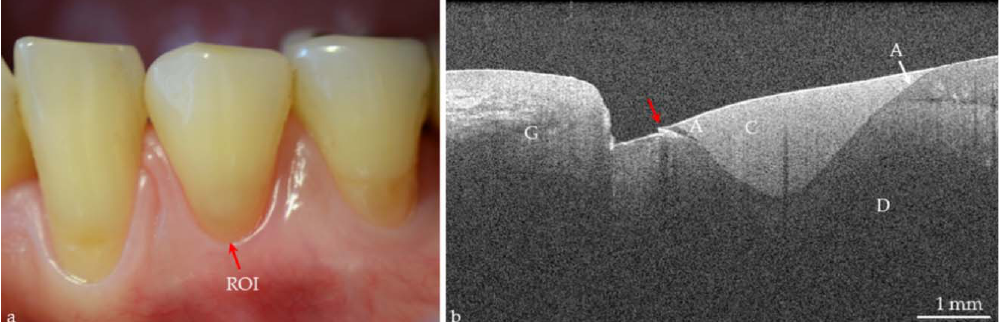
Figure 19. OCT quality control in vivo. ( a ) A cervical composite (C) restoration at a premolar 34 immediately after filling the cavity. The gingiva (G) is slightly retracted. In contrast to Figure 18 the composite has been homogeneously dispersed; ( a ) Using visual ‐ tactile assessment the restoration margins appear smooth; ( b ) However, in the OCT image at dentin (D, ROI) a margin gap in combination with a composite overhang indicates a critical area (bright line, red arrow).